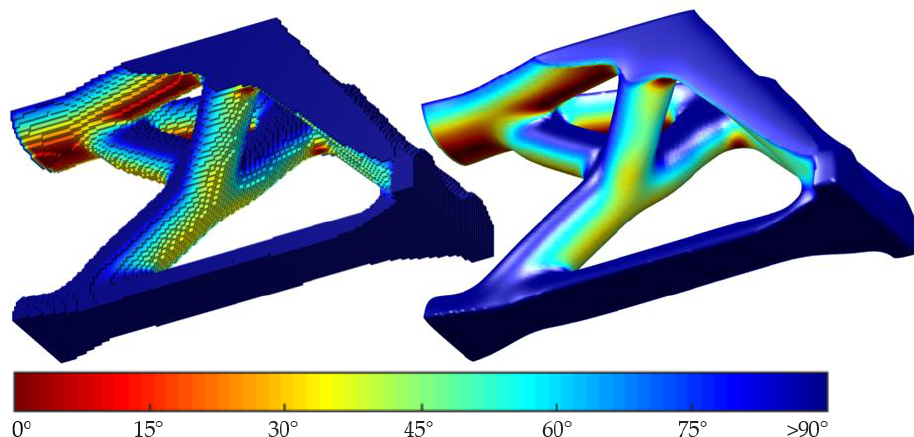
Figure 10. A sample overhanging surface angle analysis of a cantilever: (left) facets of the finite elements are colored and (right) a smoothed isosurface.